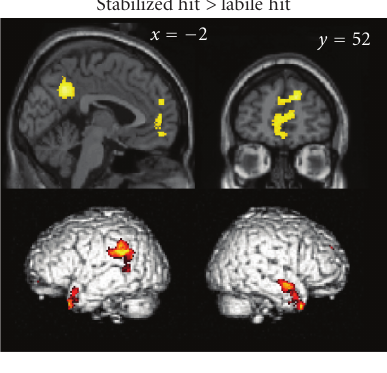
(40 faces in each condition) to a given location (one of the eight locations on the screen). The task of the subjects at test was to retrieve the associated location when a face cue